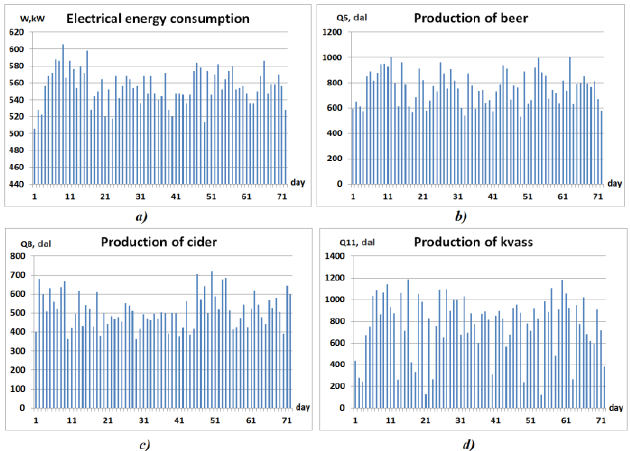
Fig. 3. Statistical data about the produced products and electrical energy consumption of a bottling line, where: a) electrical energy consumption; b) production of beer; c) production of cider; d) production of